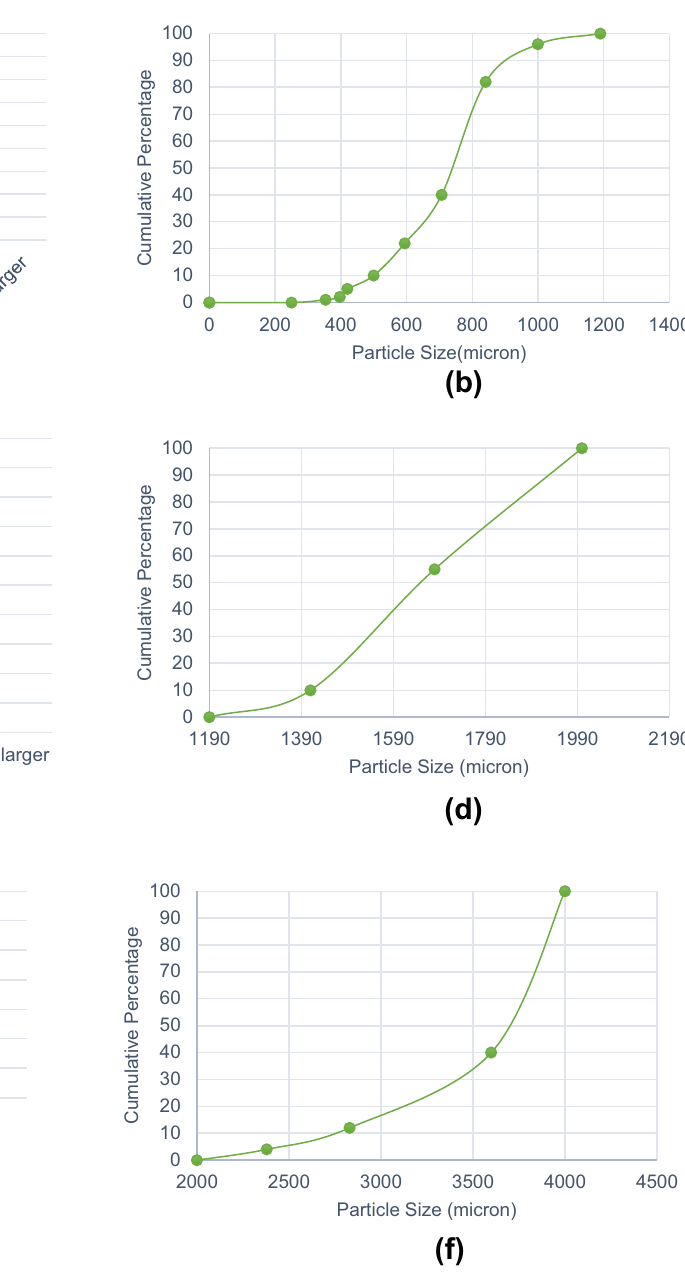
Fig. 8 a Oak Shell particle size distribution (0–1190 micron). b Oak Shell cumulative particle size distribution (0–1190 micron). c Oak Shell particle size distribution (1190–2000 micron). d Oak